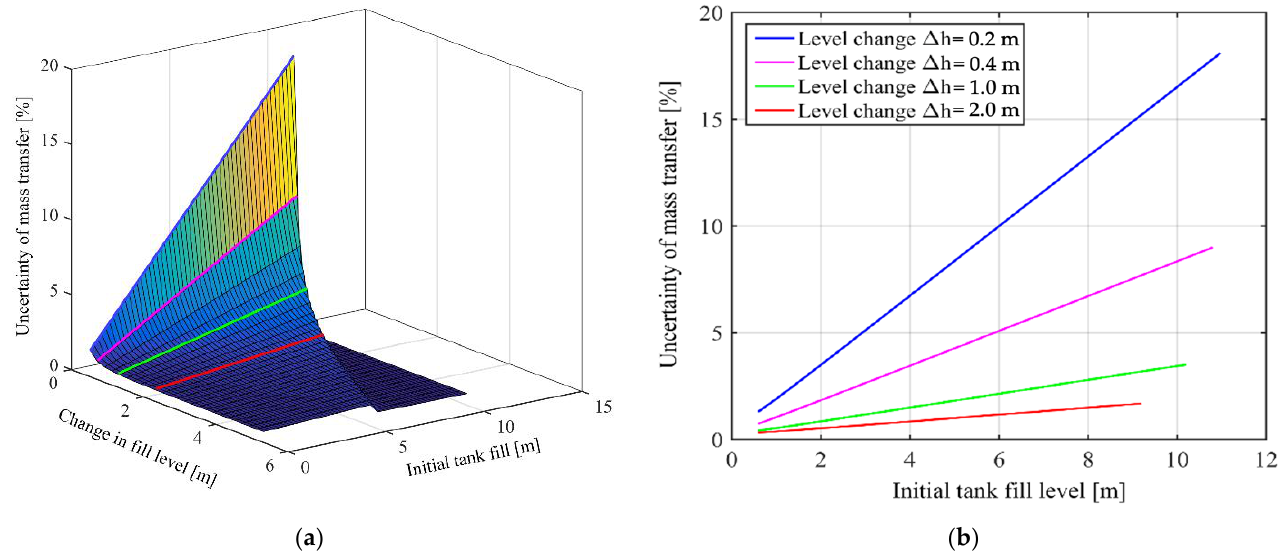
Figure 3. Dependence of the expanded uncertainty (relative form) of the transaction mass measure- ment on the tank filling level before transaction and the amount of the transaction mass: ( a ) surface plot; ( b ) surface plot projection at transaction mass values, namely 0.2, 0.4, 1, and 2 m.